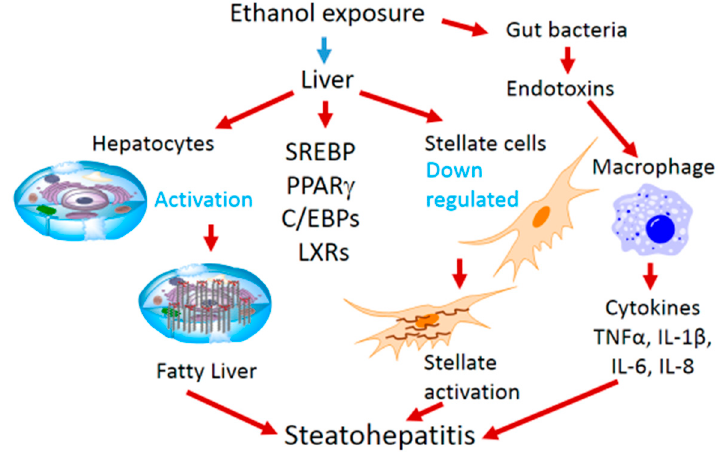
Figure 1. The role of transcription factors in hepatosteatosis and steatohepatitis.